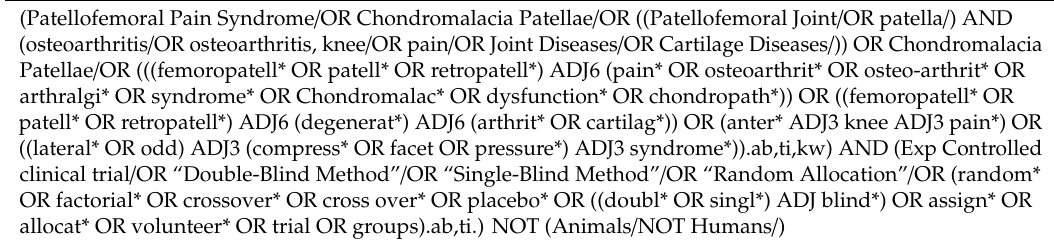
Table 1. Search string for Medline